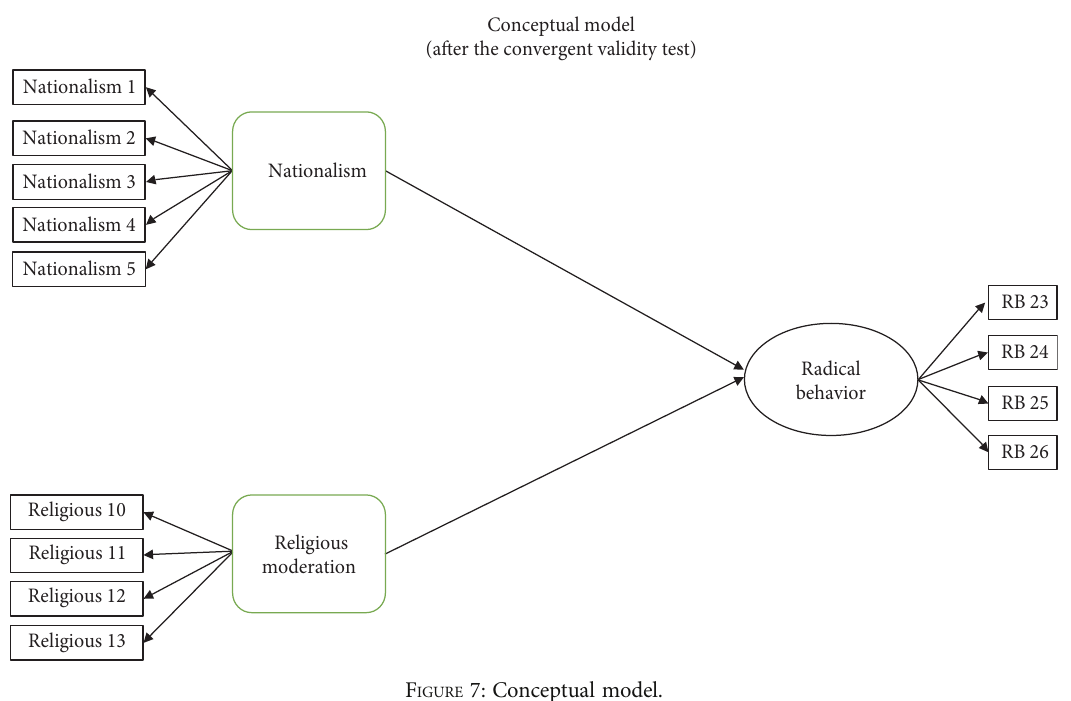
F IGURE 7: Conceptual